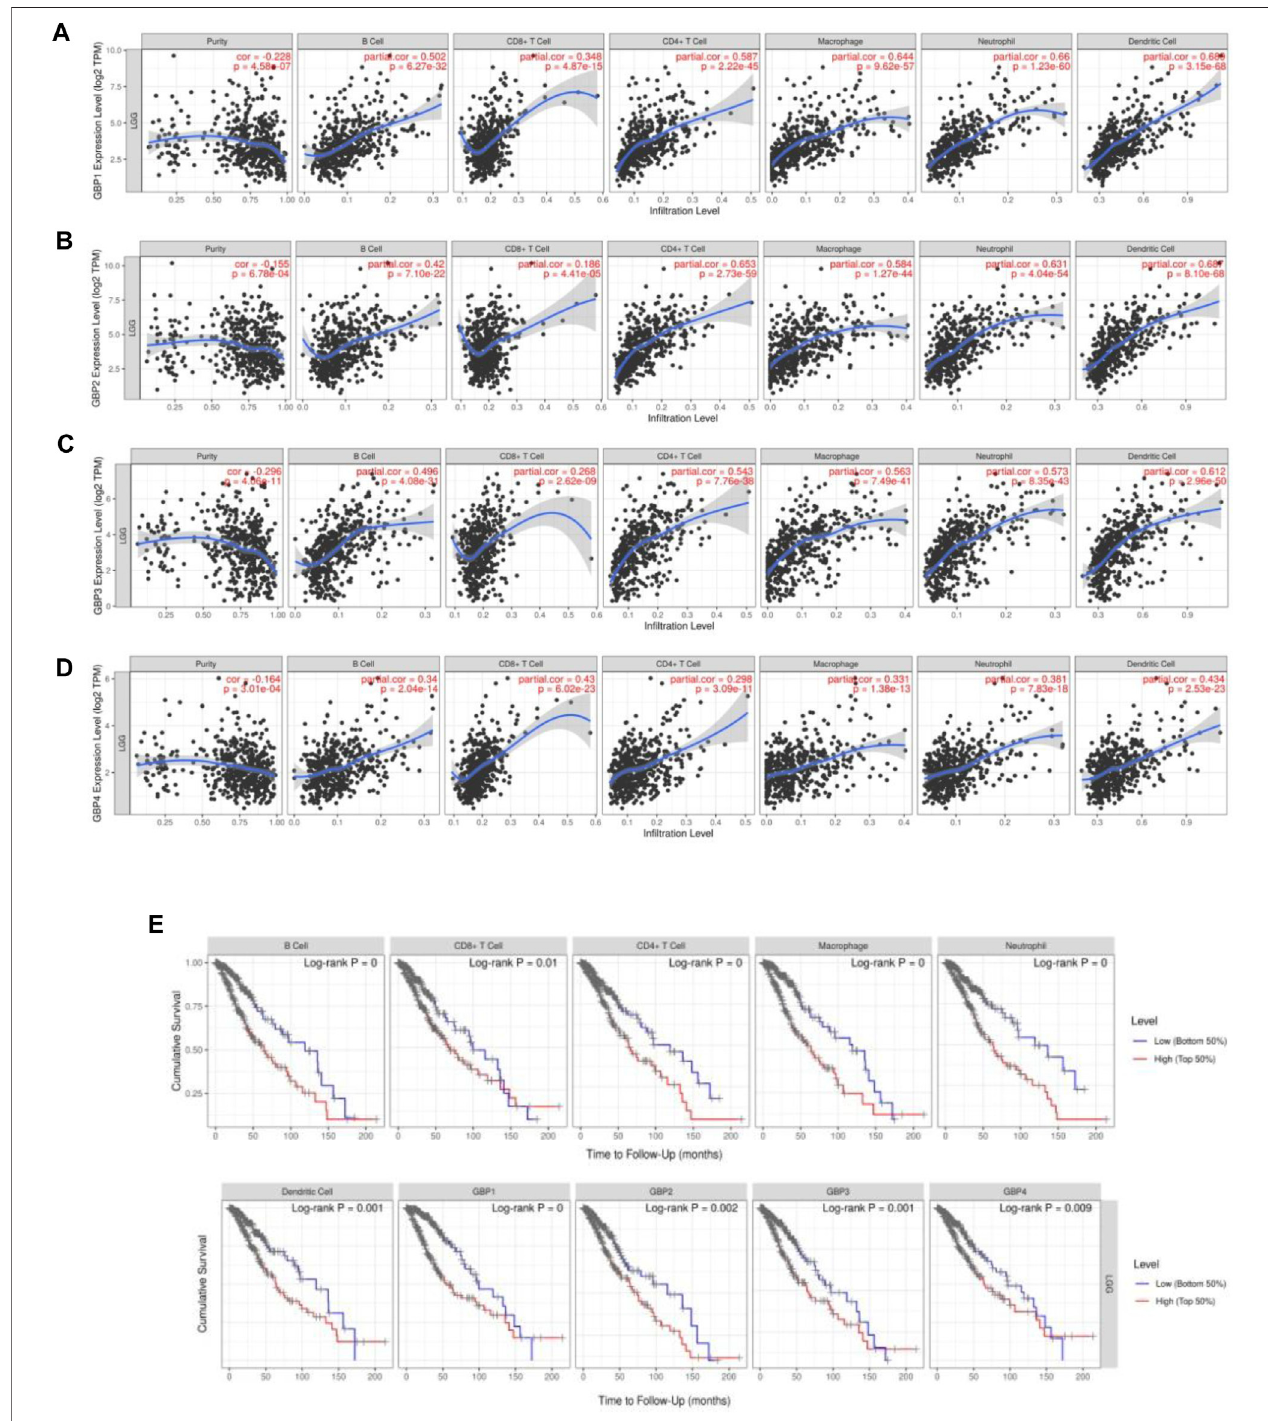
FIGURE 5 | GBP1/2/3/4 expressions were correlated with immune cell in fi ltration levels in LGG patients [Tumor Immune Estimation Resource (TIMER)]. The correlation between the abundance of immune cells and the expression of (A) GBP1, (B) GBP2, (C) GBP3, and (D) GBP4 in LGG. (E) Kaplan – Meier plots of different immune-in fi ltrating cells and GBP1, 2, 3, 4 in LGG.